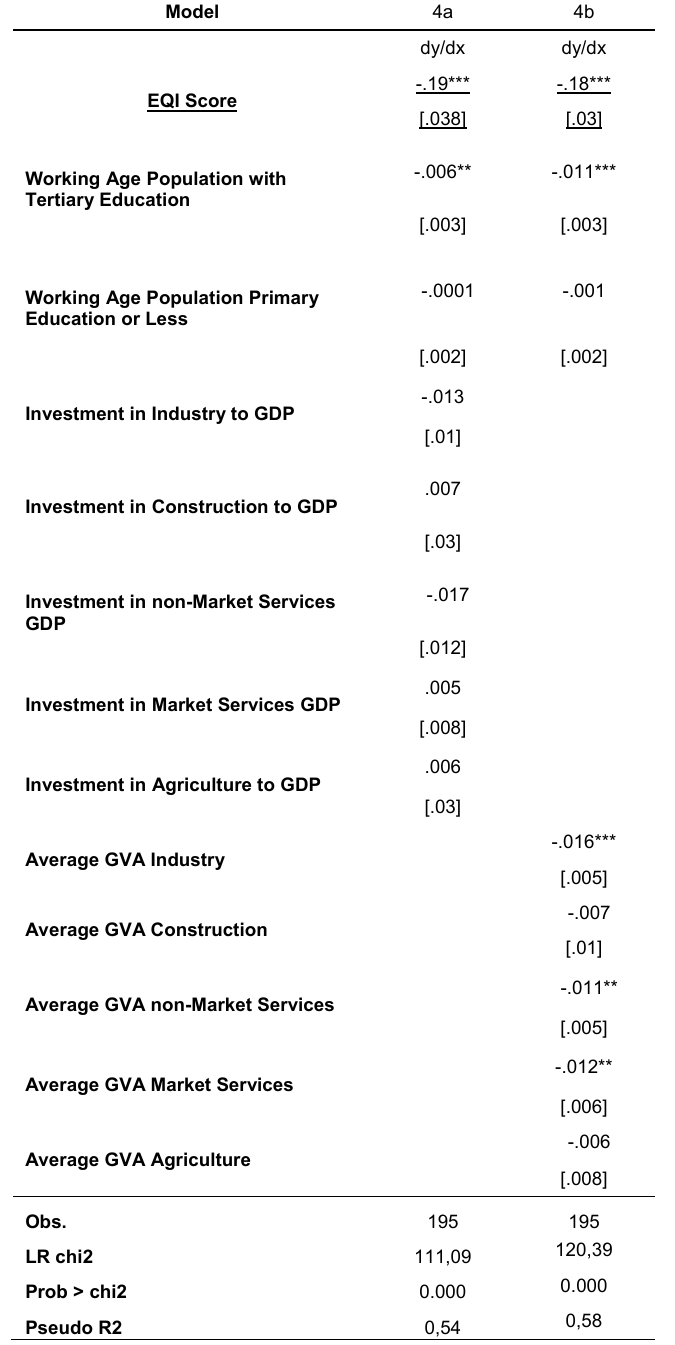
Table 5. Marginal effects on probability Y=1|X. Group